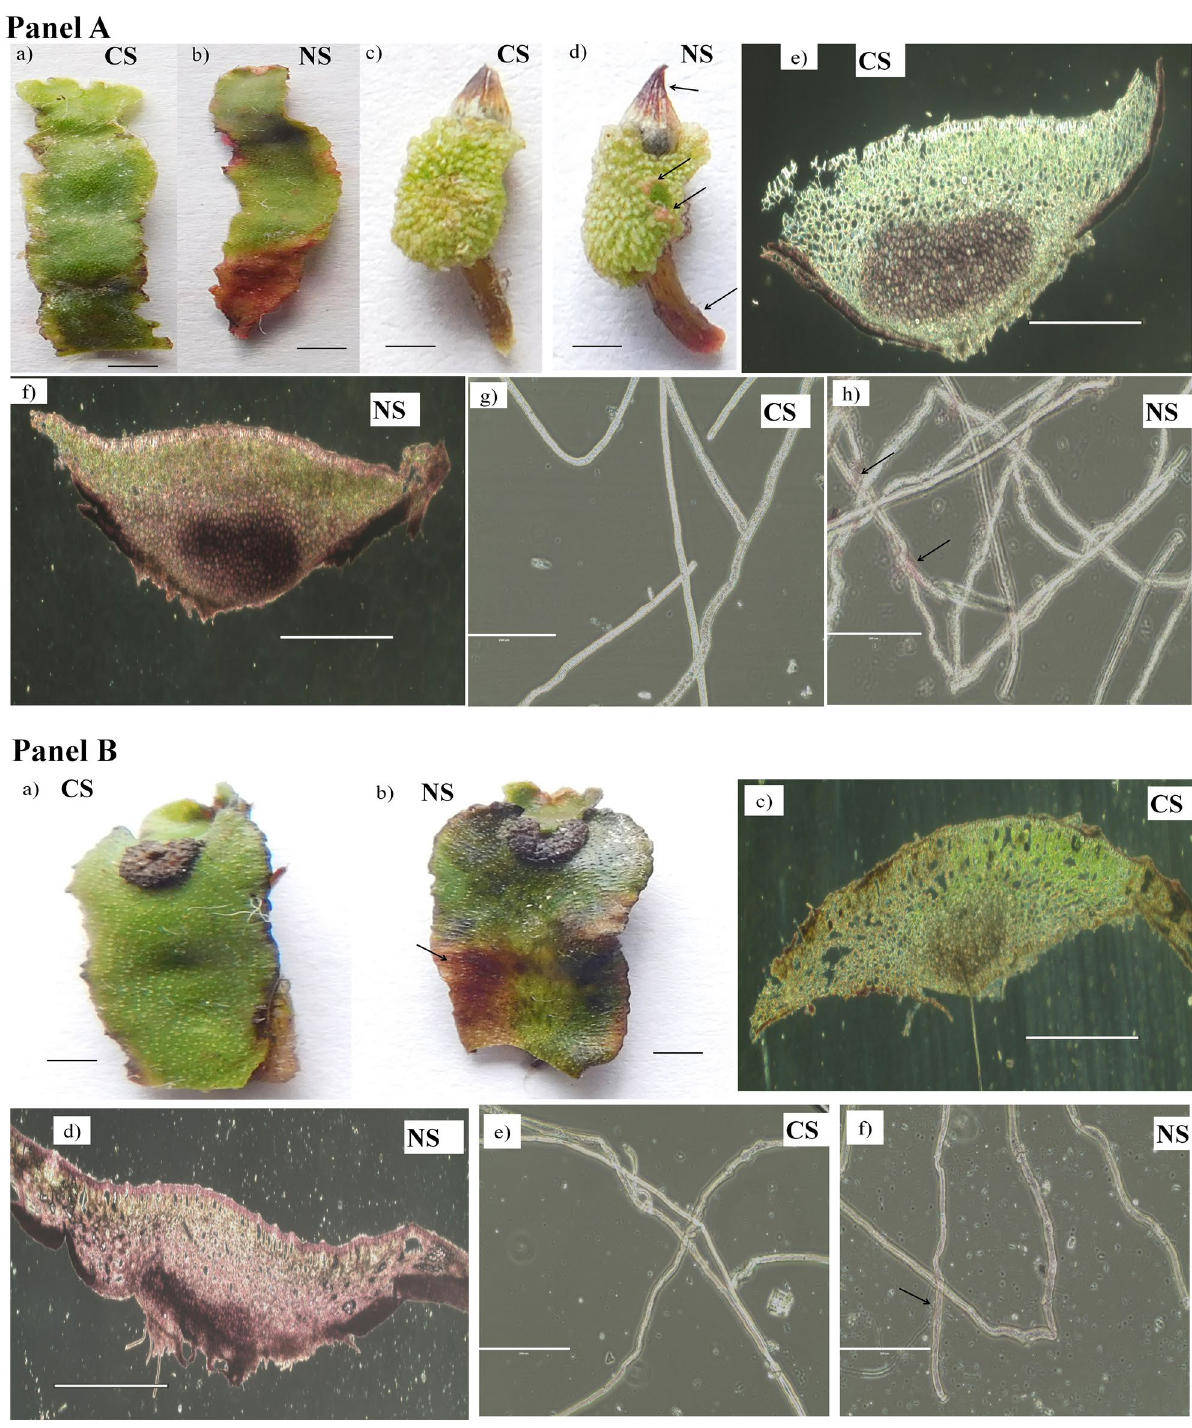
Figure 3. Nickel impacts morphology and reproductive structures of Asterella wallichiana and Plagiochasma appendiculatum . Panel (A) : (a,b) A . wallichiana thalli collected from the Ni-excess sites (NS), (b) showed browning of the tissues as an indicator of senescence, compared with that collected from the control sites (CS) (a) . (c,d) accumulation of Ni ions (dark pink color, arrows) in the A . wallichiana sporophyte collected from the NS (d) compared with those collected from CS (c) as revealed by dimethylglyoxime staining. (e,f) Transverse section of the A . wallichiana thalli collected from the NS (f) showed higher accumulation of Ni ions (pink color, arrows), compared with that collected from the CS (e) . (g,h) A . wallichiana rhizoids collected from the NS (h) showed higher accumulation of Ni ions (light pink color, arrows), compared with that collected from CS (g) . Panel (B) : (a,b) P . appendiculatum thalli collected from the Ni-excess sites (NS) (b) showed browning of the tissues as an indicator of senescence, compared with that collected from the control sites (CS) (a) . (c,d) Transverse section of the P . appendiculatum thalli collected from the NS (d) showed higher accumulation of Ni ions (pink color, arrows), compared with that collected from the CS (c) . (e,f) P . appendiculatum rhizoids collected from the NS (f) showed higher accumulation of Ni ions (light pink color, arrows), compared with that collected from CS (e) . Images of panel (A) (a–d) and panel (B) (a,b) were taken by Nikon L840 at 300 dpi. Scale bars represent 1000 µm for panel (A) (e,f) and panel (B) (c,d) and 100 µm for panel (A) (g,h) and panel B (e,f)